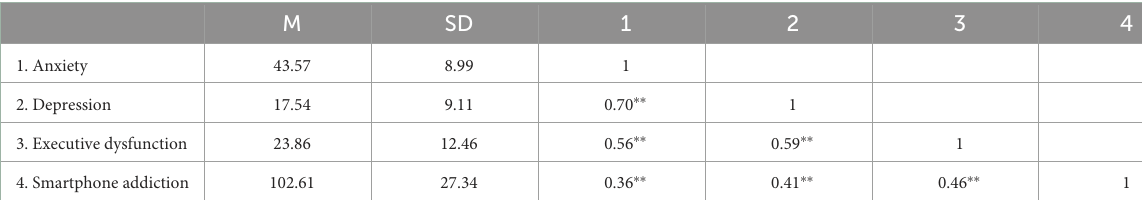
TABLE 1 The correlation analysis between study variables.